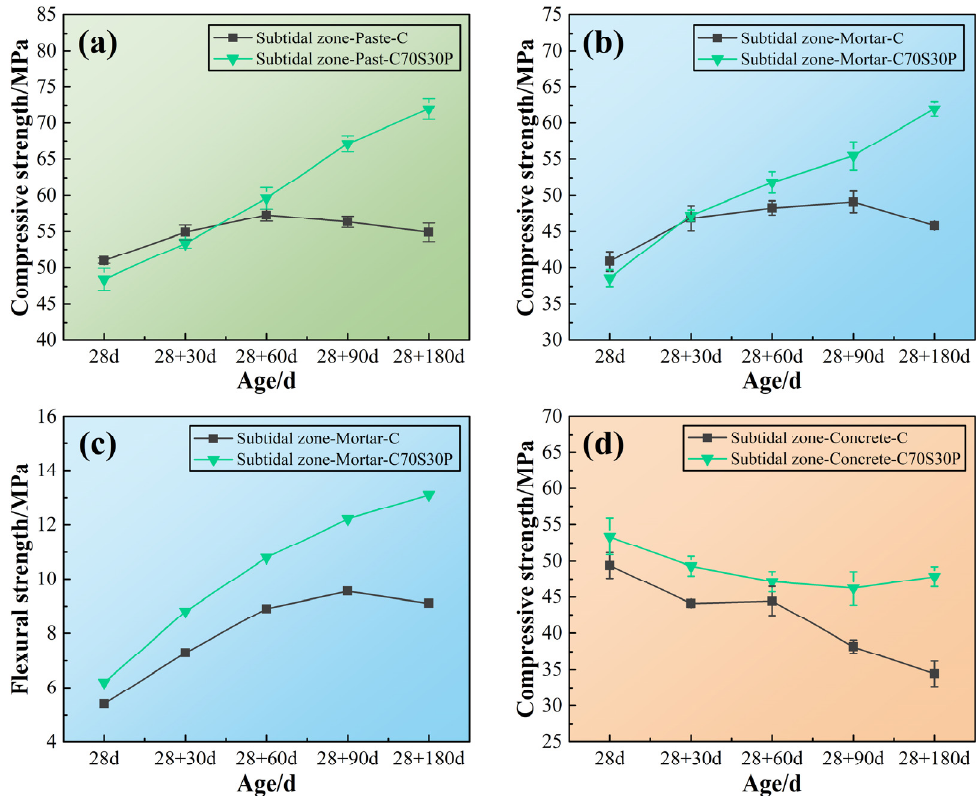
Figure 17. The mechanical properties of CBRM serving in the subtidal zone simulated environment. ( a ) CBRM-Paste, ( b , c ) CBRM-Mortar, and ( d )